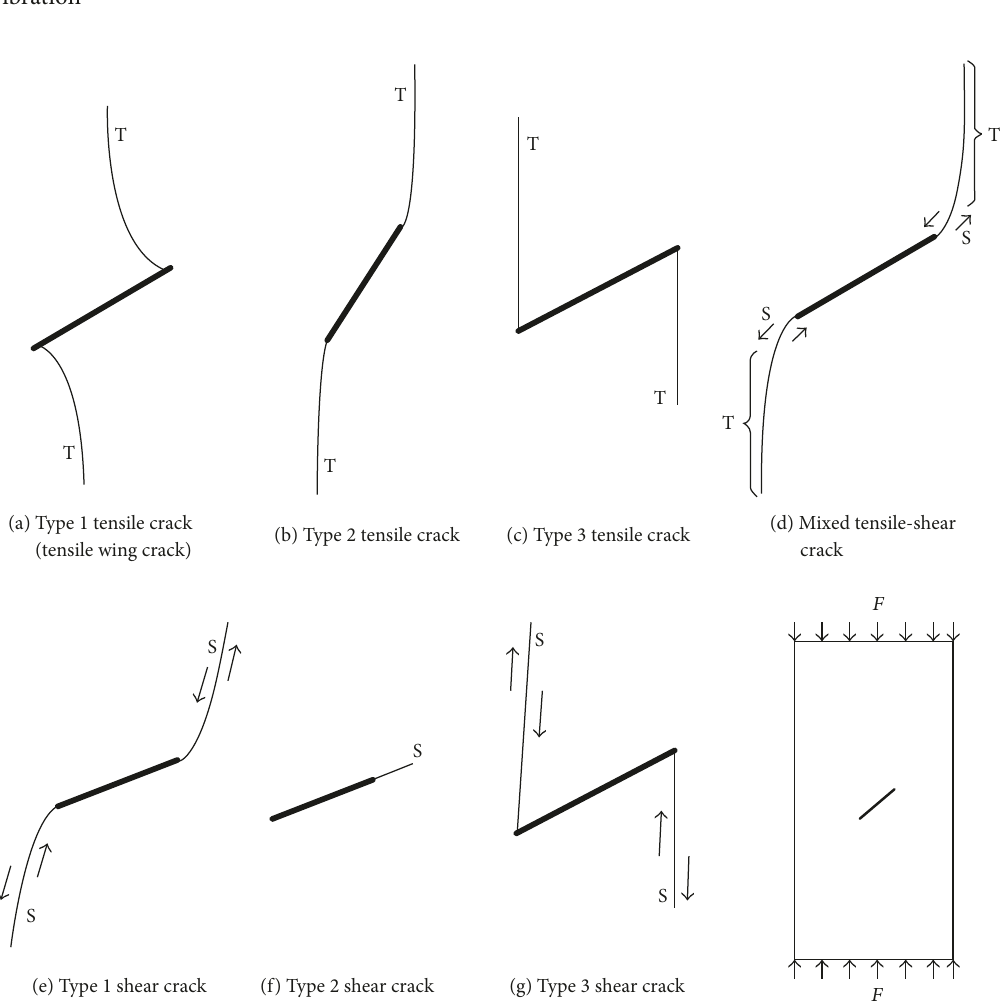
increased with the increase of flaw inclination angle 𝛽 from 30 ∘ to 90 ∘ . In addition, when flaw inclination angle 𝛽 < 15 ∘ or 𝛽 > 75 ∘ , the CD stress 𝜎 cd is substantially equal to the peak strength. With the decrease of flaw length 𝐿 , the effect is relatively more